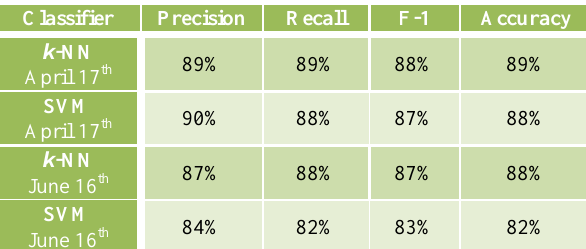
Table 1. The average performances obtained over all